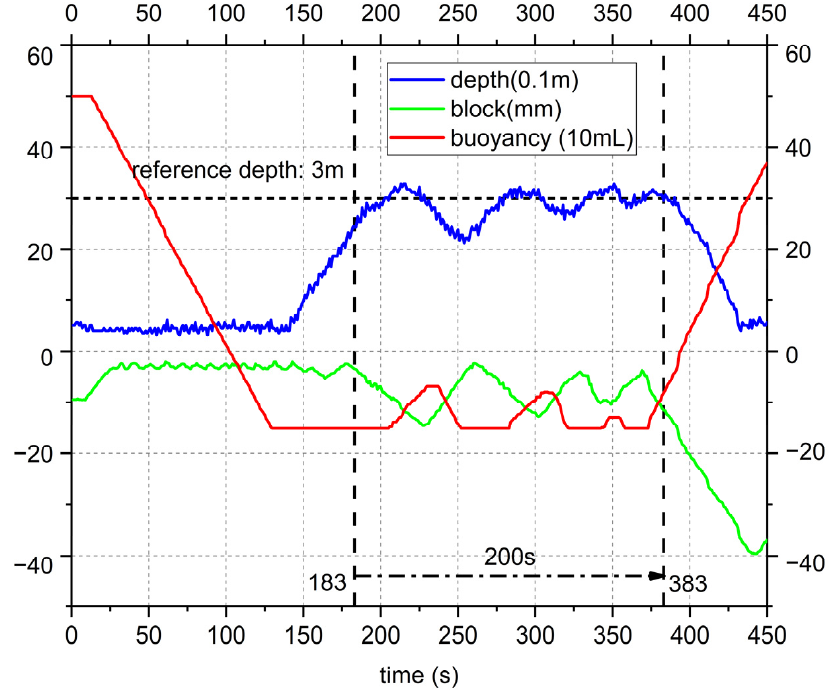
Figure 10. The depth, mass block location, and buoyancy changed with time when the robot swam the rectangle.